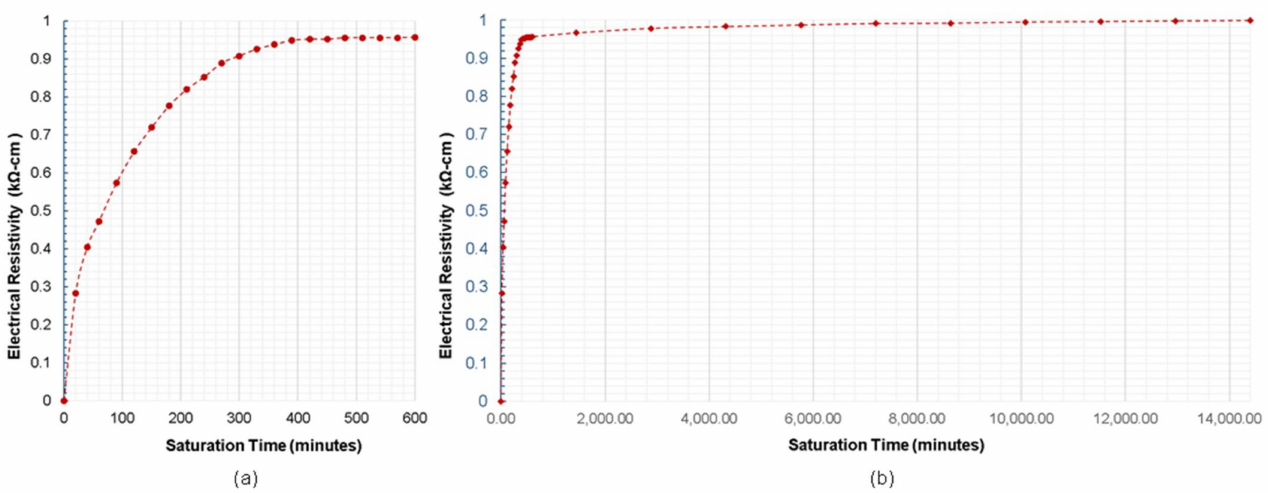
Figure 11. Relationship of the surface saturation of concrete with respect to the relative ER measured directly above the rebar with saturation time of ( a ) up to 600 min ( b ) 14,400 min (10